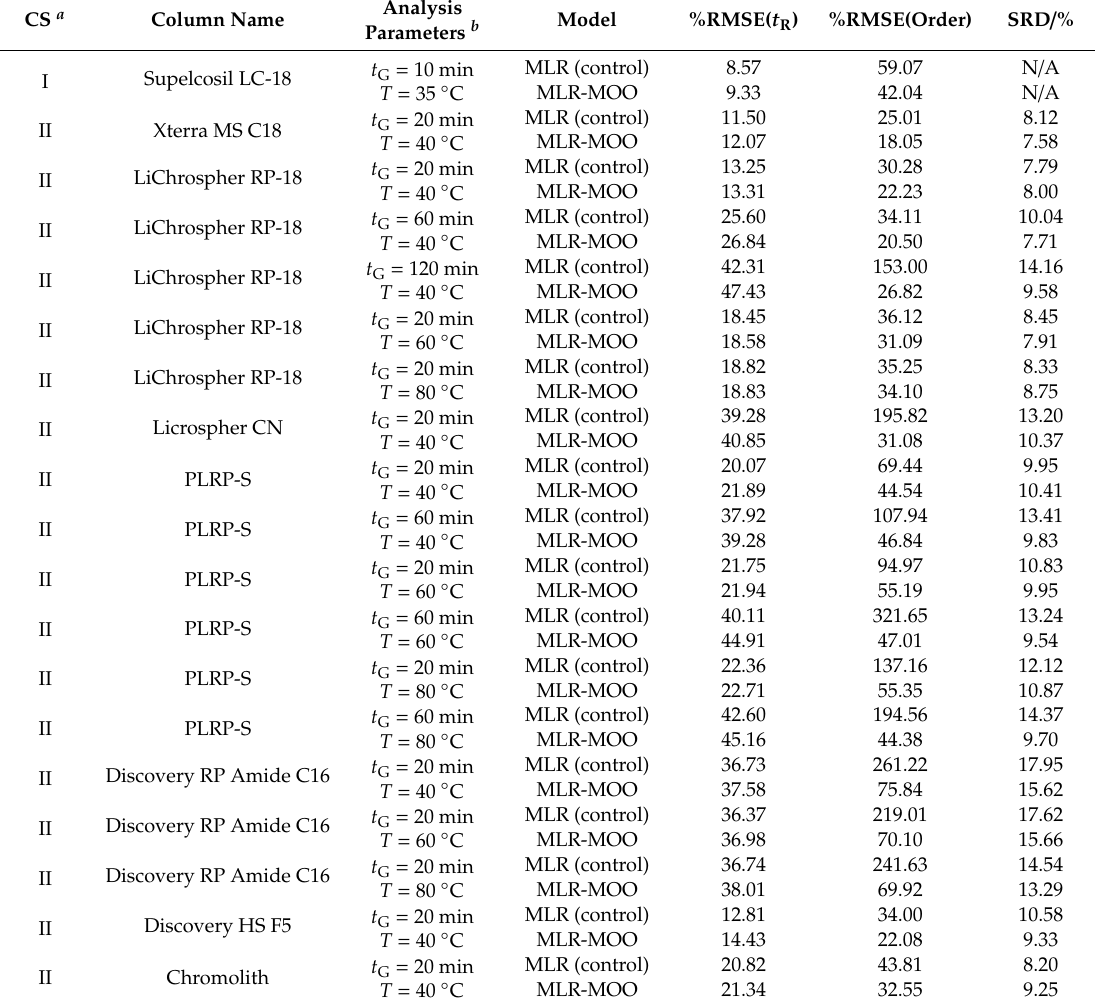
Table 1. Summary of model performances for the first and second case studies.